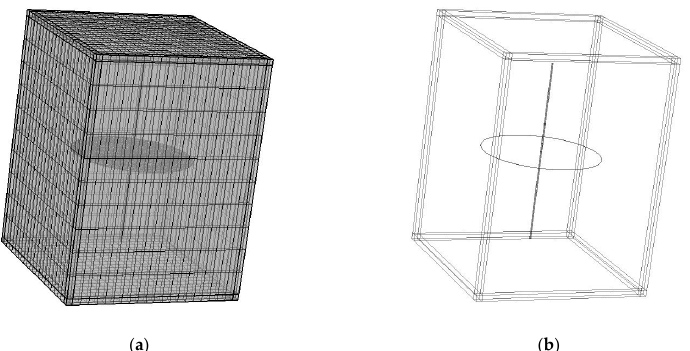
Figure 3. Computing domain diagram : ( a ) overall meshing diagram (hexahedral mesh); ( b ) model line drawing.